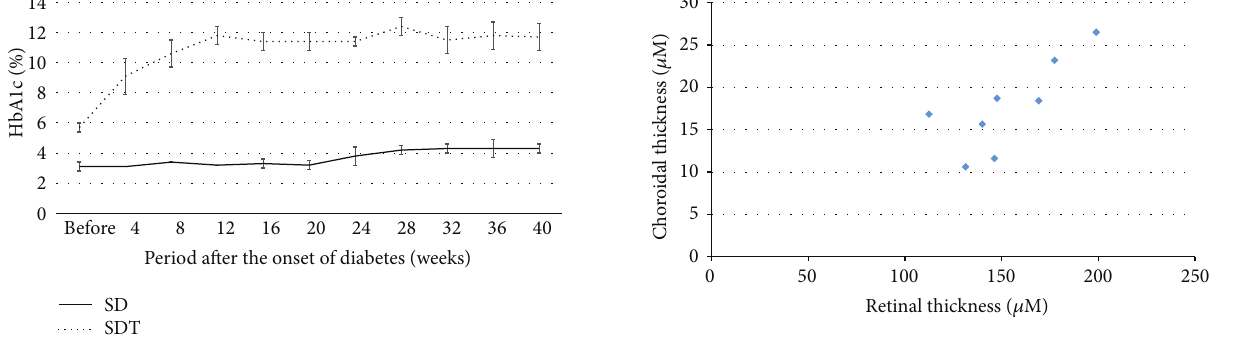
Figure 3: HbA1c levels of the study animals. The mean HbA1c levels of the SD rats are significantly lower than those of the SDT rats.